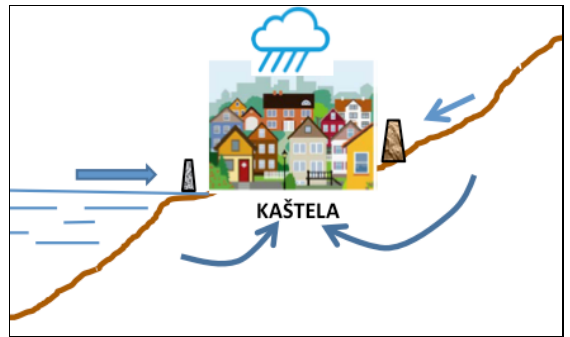
Figure 1. Rainfall, underground and sea water pressure on the coastal zone of the City of Ka š tela (Margeta et al. 2019)